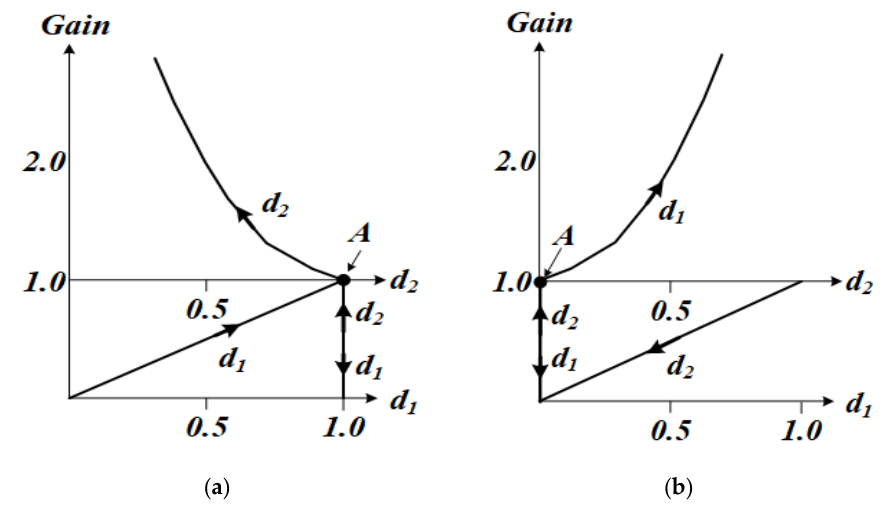
Figure 2. Bidirectional boost-buck converter duty gain. ( a ) One arm has a fixed fertilization ratio of 1; ( b ) The two arms independently adjust the fertilization rate.